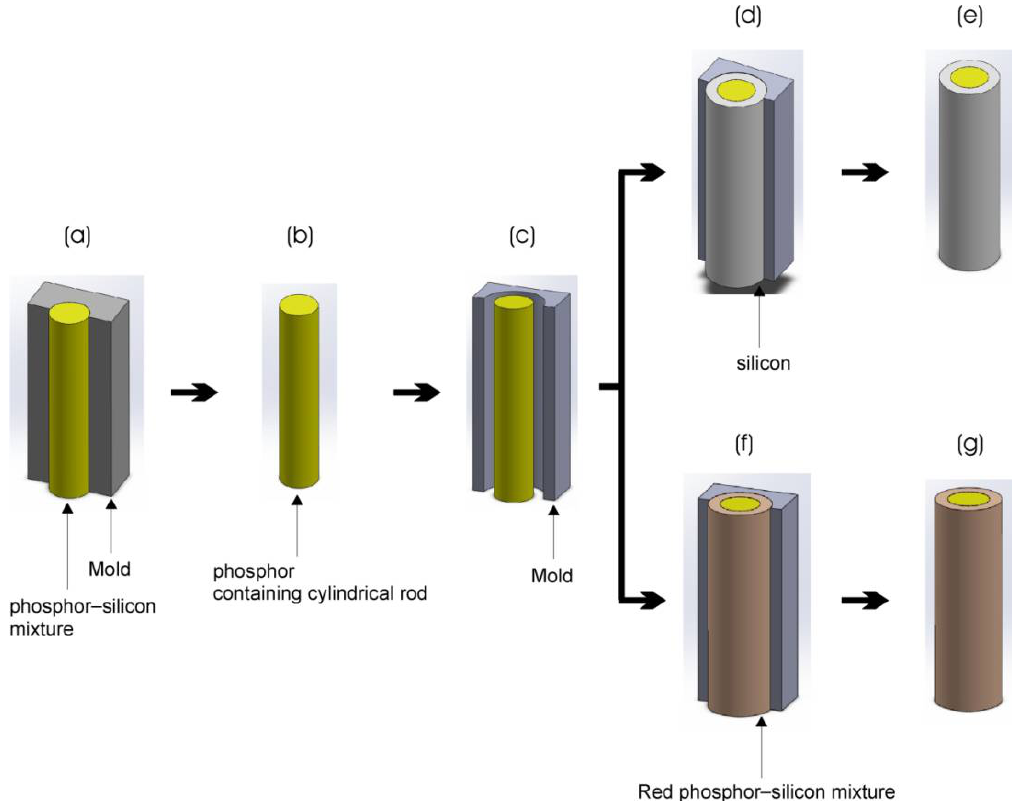
Figure 2. Schematic diagram of process flow charts in this study.